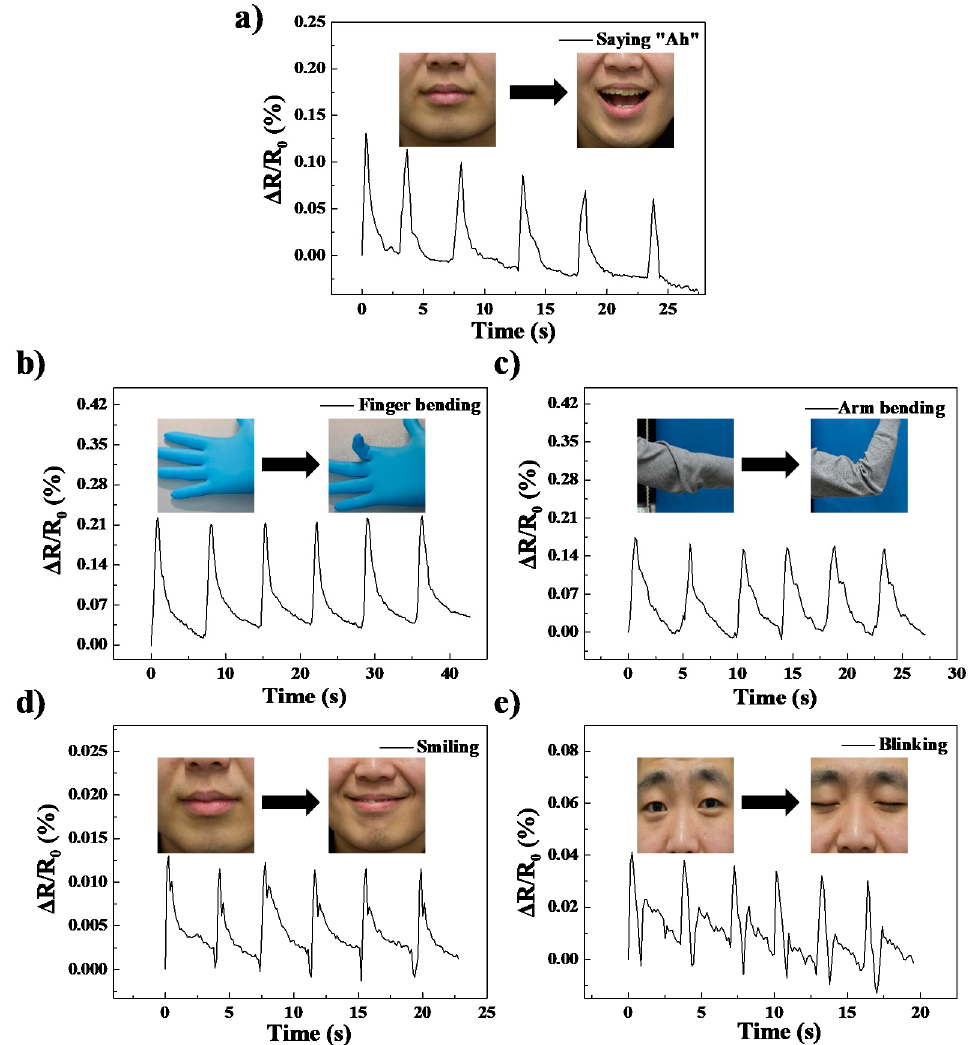
Figure 12. The recorded relative resistance change in the electronic sensor with the volunteer performing different motions: ( a ) saying ‘Ah’; ( b ) finger bending; ( c ) arm bending; ( d ) smiling; and ( e ) blinking.